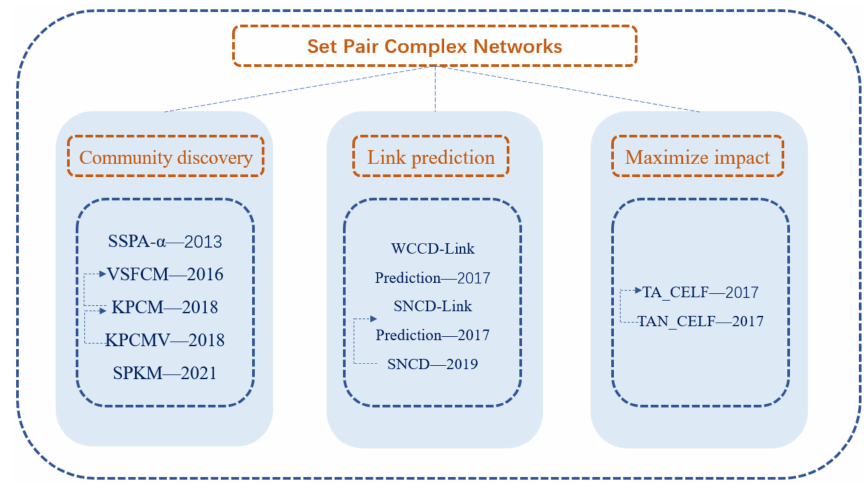
Figure 3. Main algorithms of set pair complex networks and their